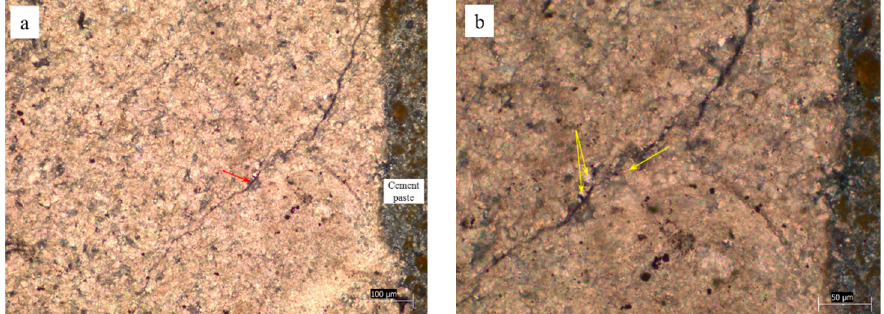
Figure 6. Expansion cracks in concrete microbar of YMS1 cured in TMAH solution for 98 days: ( a ) crack in dolomite region; ( b ) dolomite around the crack.